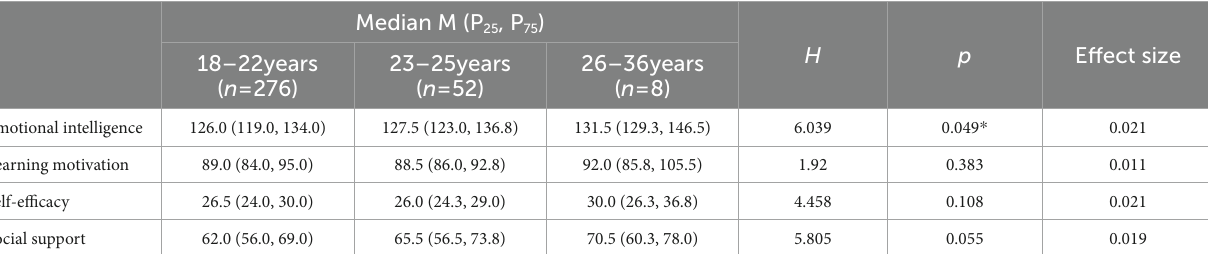
TABLE 5 Differences between the different age groups.